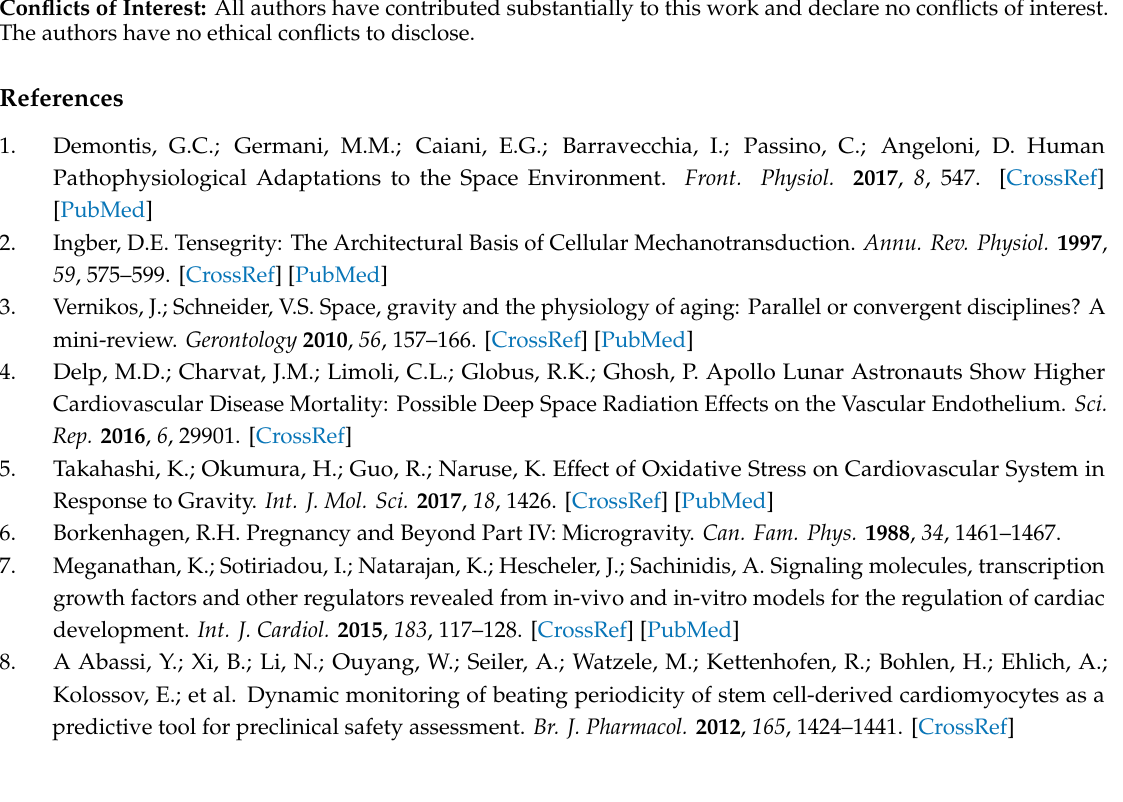
Figure S1: E ff ects of hypergravity, microgravity and hypergravity within an individual parabola. Author Contributions: A.S., A.A., J.H., and R.H. designed the study. A.A., A.S., J.H., Y.L., S.B., and H.B. performed the experiments. A.S., A.A., R.H., and H.B. wrote the manuscript. Funding: This work was funded by the Bundesministerium für Wirtschaft und Energie (BMWi) (BASIS project). separate days, as part of their 66th Parabolic Flight Campaign in